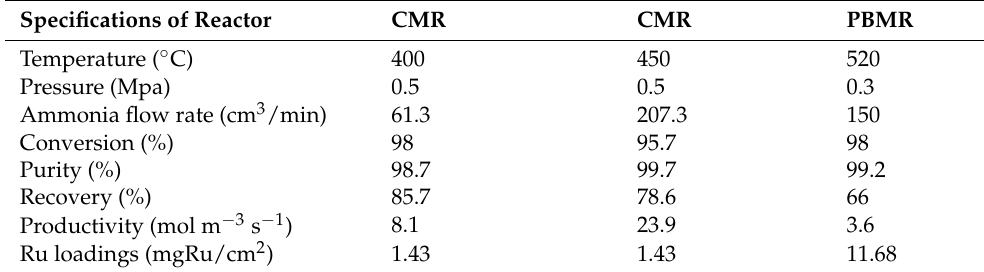
Table 11. Comparison of the performance of catalytic membrane reactor with the packed bed membrane reactor. Reprinted with permission